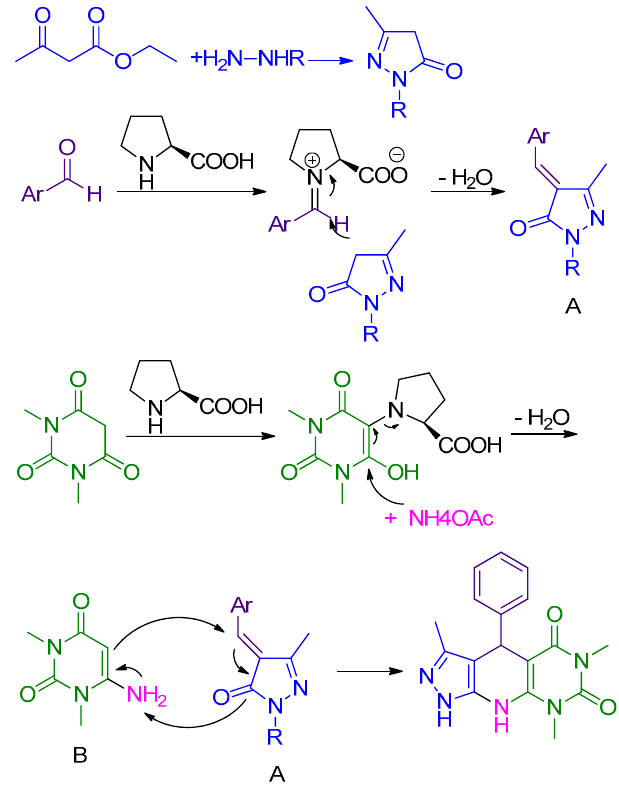
Scheme 4. Proposed mechanism for the synthesis of compound 6 using L -proline. Table 4. One pot, four-component synthesis of pyrazolo-[4 1 ,3 1 :5,6]pyrido[2,3- d ]pyrimidine-diones in refluxing water using a catalytic amount of nano-ZnO.